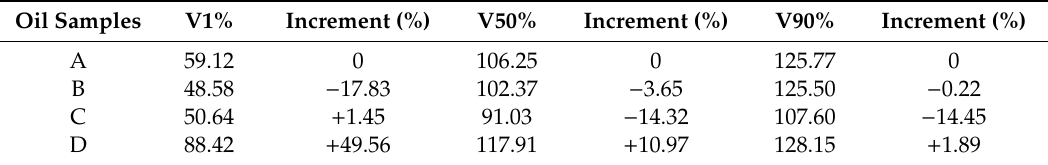
Table 6. Probability of 1%, 50% and 90% lightning impulse breakdown voltage values of various oil samples with di ff erent